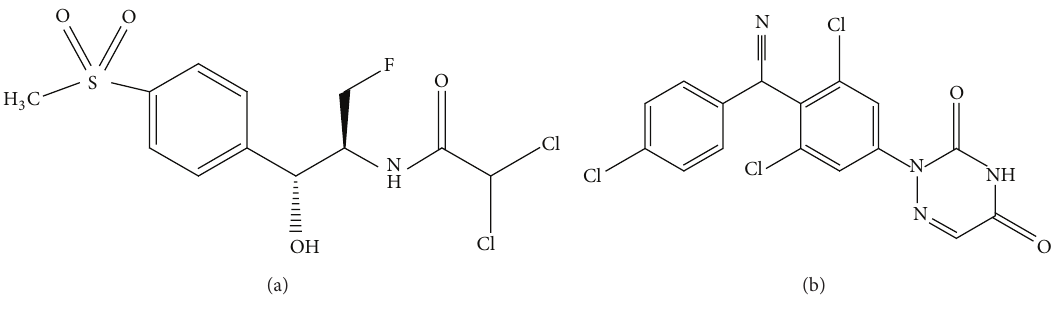
Figure 1: Chemical structures of florfenicol (a) and diclazuril